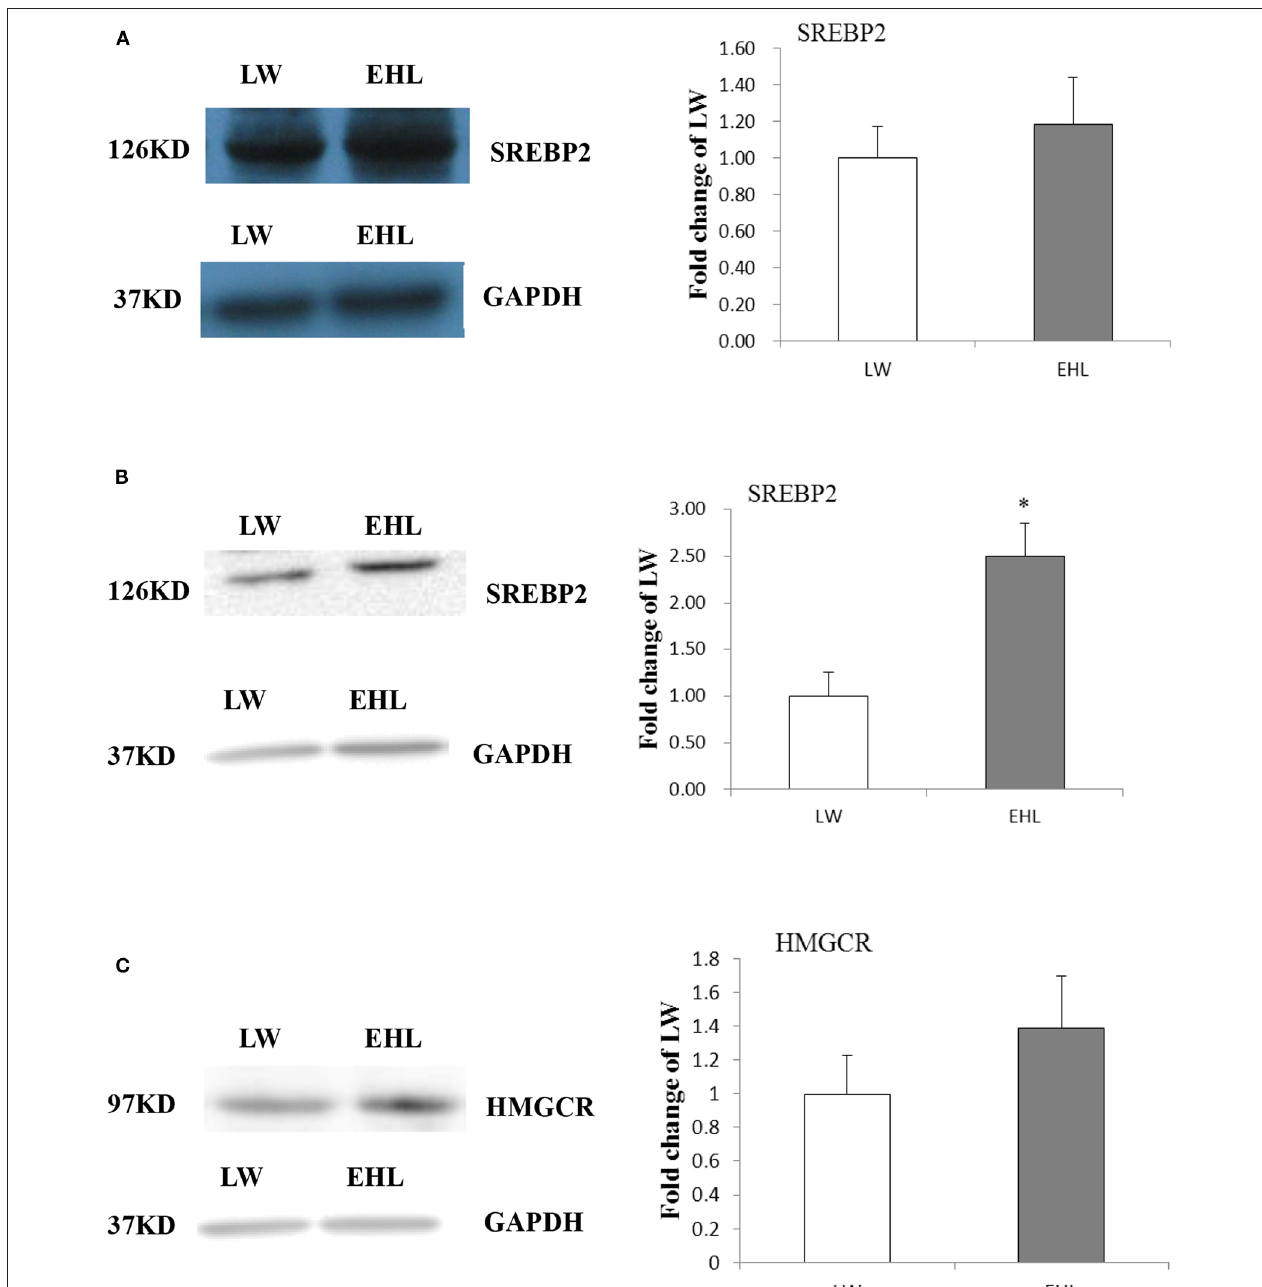
FIGURE 3 | Hepatic SREBP2 and HMGCR protein content. (A) Expressed SREBP2 protein content at birth; (B) expressed SREBP2 protein content at weaning; (C) expressed HMGCR protein content at weaning ( n = 6 piglets each time point per breed). * P < 0.05. Data are presented as mean ± SEM.